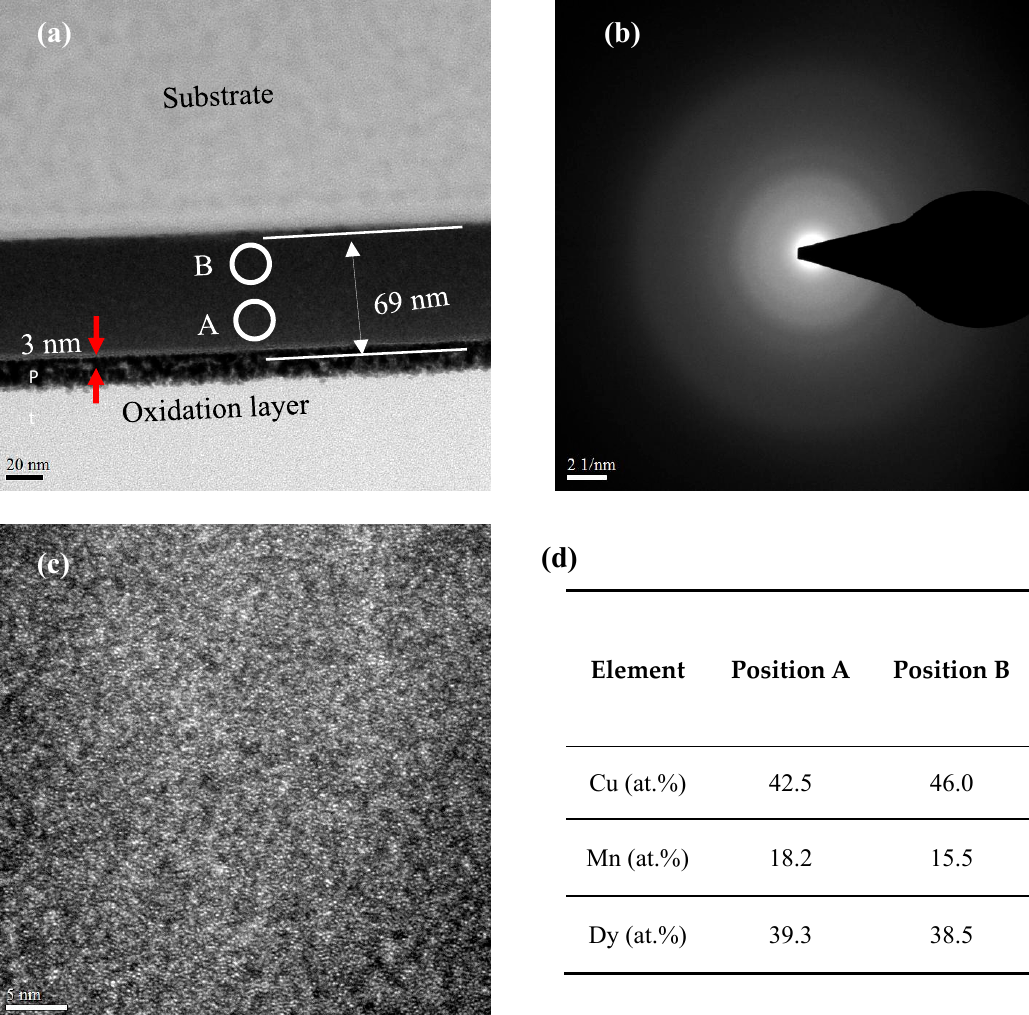
Figure 3. TEM micrographs of Cu–Mn films with 40 at.% Dy addition annealed at 300 ° C: ( a ) bright field of cross section; ( b ) selected-area electron diffraction; ( c ) HRTEM micrographs; ( d ) EDX analysis.